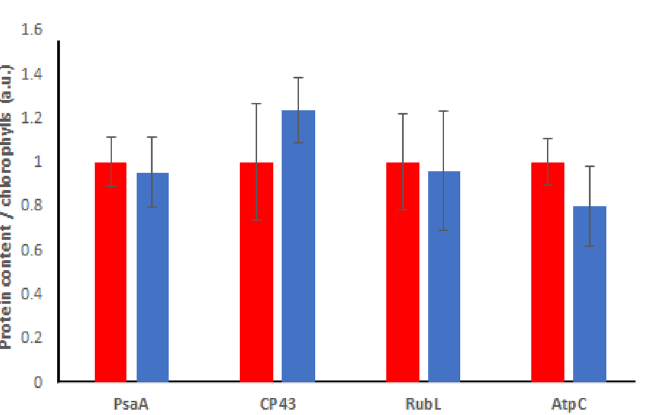
Figure 7. Immunoblotting quantification of photosynthetic subunits. The bands appearing upon western blot analysis were quantified by densitometry and normalized to the control case to determine the protein content in the Cy5 treated